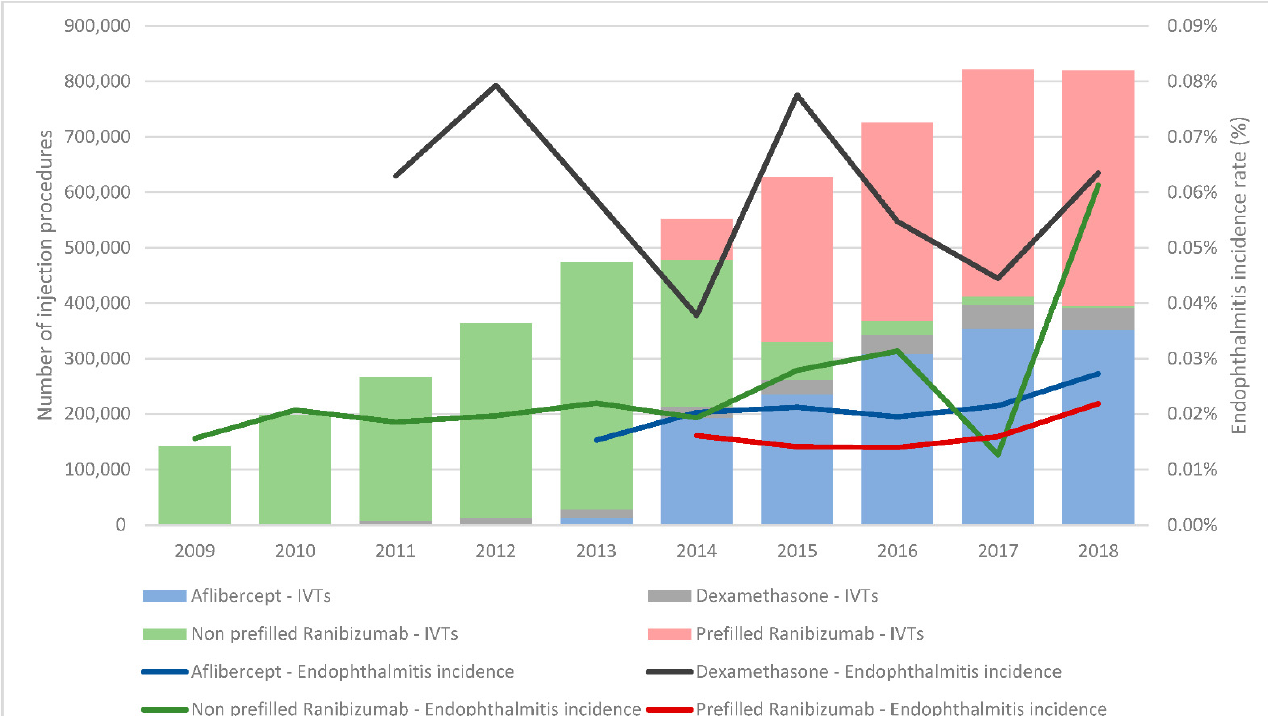
4 of 12 Table 1. Baseline demographics of patients with intravitreal injections of corticosteroids or anti ‐ VEGF (vascular endothelial growth factor) agents from 2009 to 2018. Characteristics